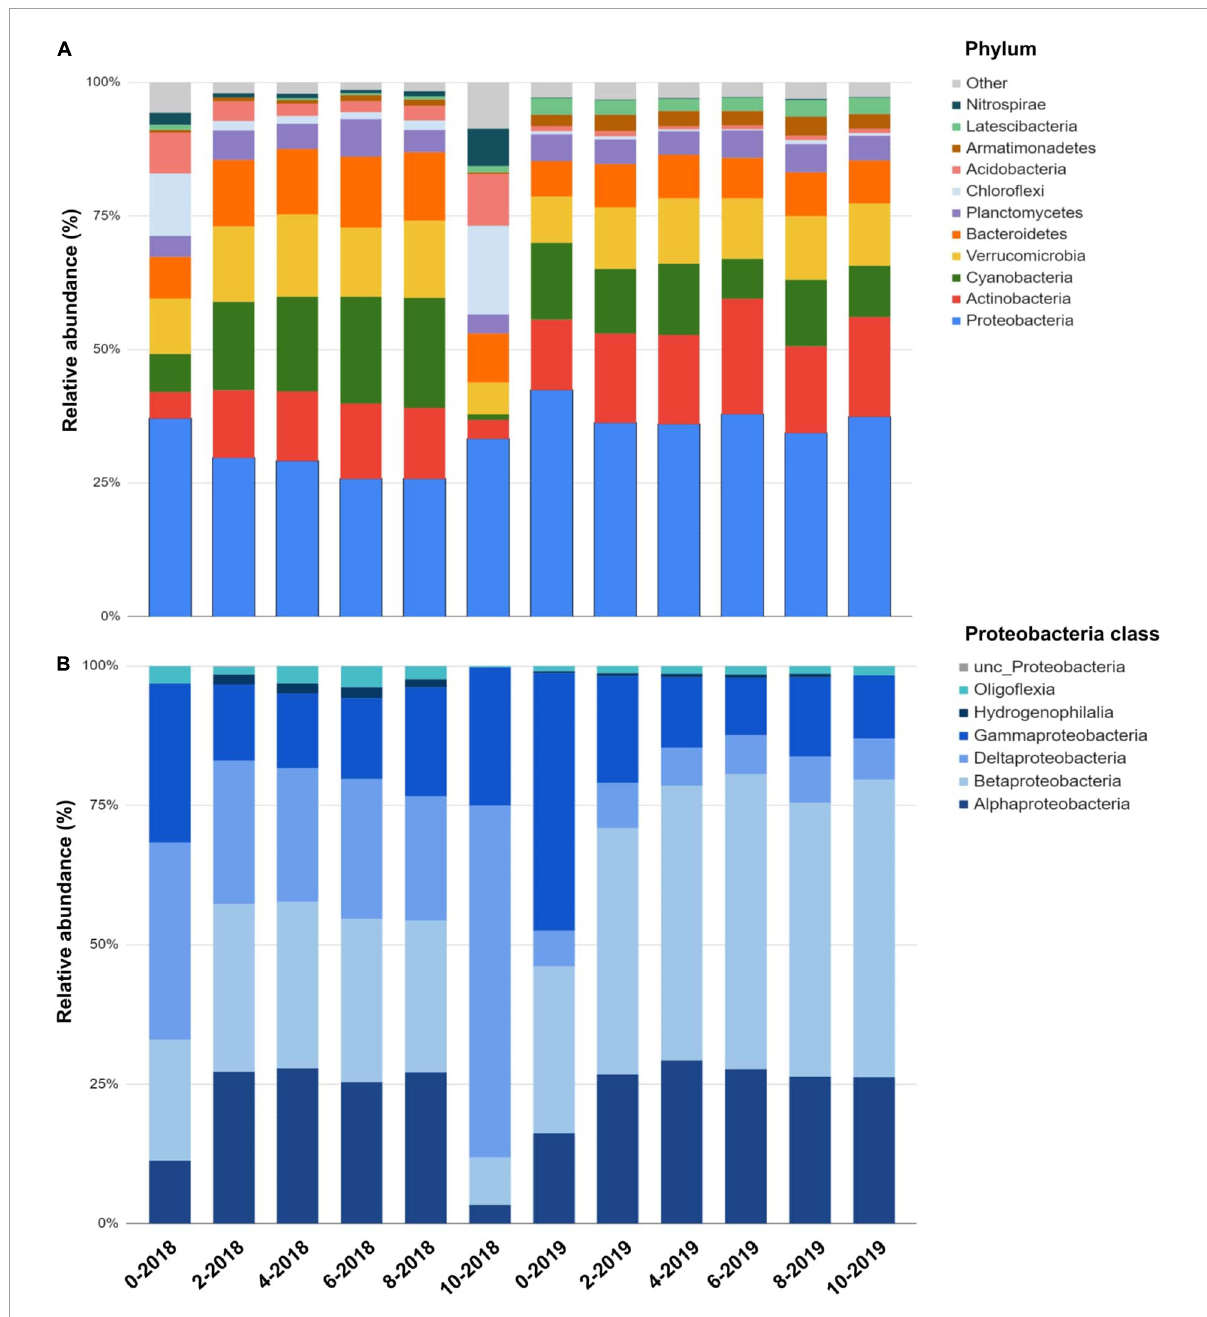
FIGURE2 Microbial community structure in Lake Cote for the two sampling dates in 2018 and 2019 according to depth. (A) Profile according to phylum level, the category “others” includes Spirochaetes, Firmicutes, Nistropinae, Patescibactera, Omnitrophicaeota, Rokubacteria, Kiritimatiellaoeta, TA06, and Zixibacteria. (B) Proteobacteria classes relative abundance along the Lake Cote water column in 2018 and 2019. Deltaproteobacteria was dominant in the hypolimnion during lake stratification.